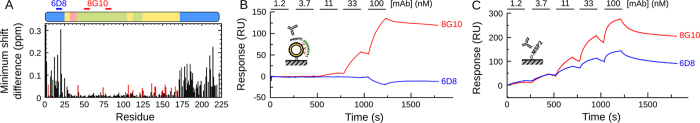
Membrane anchoring recapitulates the solvent exposure of the central variable region and the masking of an N-terminal epitope in recombinant MSP2. (A) NMR chemical shift perturbations of His-tagged MSP2 in DOGS-NiNTA/DPC micelles indicate marked differences at the conserved N and C-terminal portions of the protein. Red bars indicate chemical shift perturbations of Asp/Glu residues due to local pH at the micelle surface. Sequence features of MSP2 are shown above, with conserved regions in blue, repeats in green, allele-specific dimorphic regions in yellow and polymorphic regions in pink. (B) SPR sensorgrams demonstrating the complete loss of N-terminal recognition of lipid-bound FC27 MSP2 by mAb 6D8 despite the dose-dependent binding of the strain-specific mouse antibody 8G10. The locations of the 6D8 and 8G10 epitopes are indicated in (A). (C) The binding of mAb 8G10 and mAb 6D8 to MSP2 is concentration dependent in the absence of lipids.